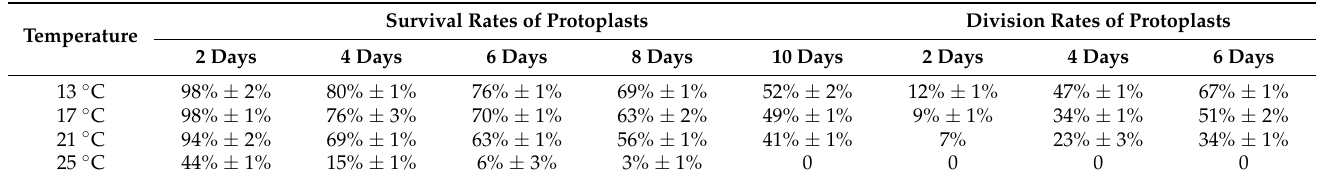
Table 1. Survival rates and division rates of protoplasts incubated at different